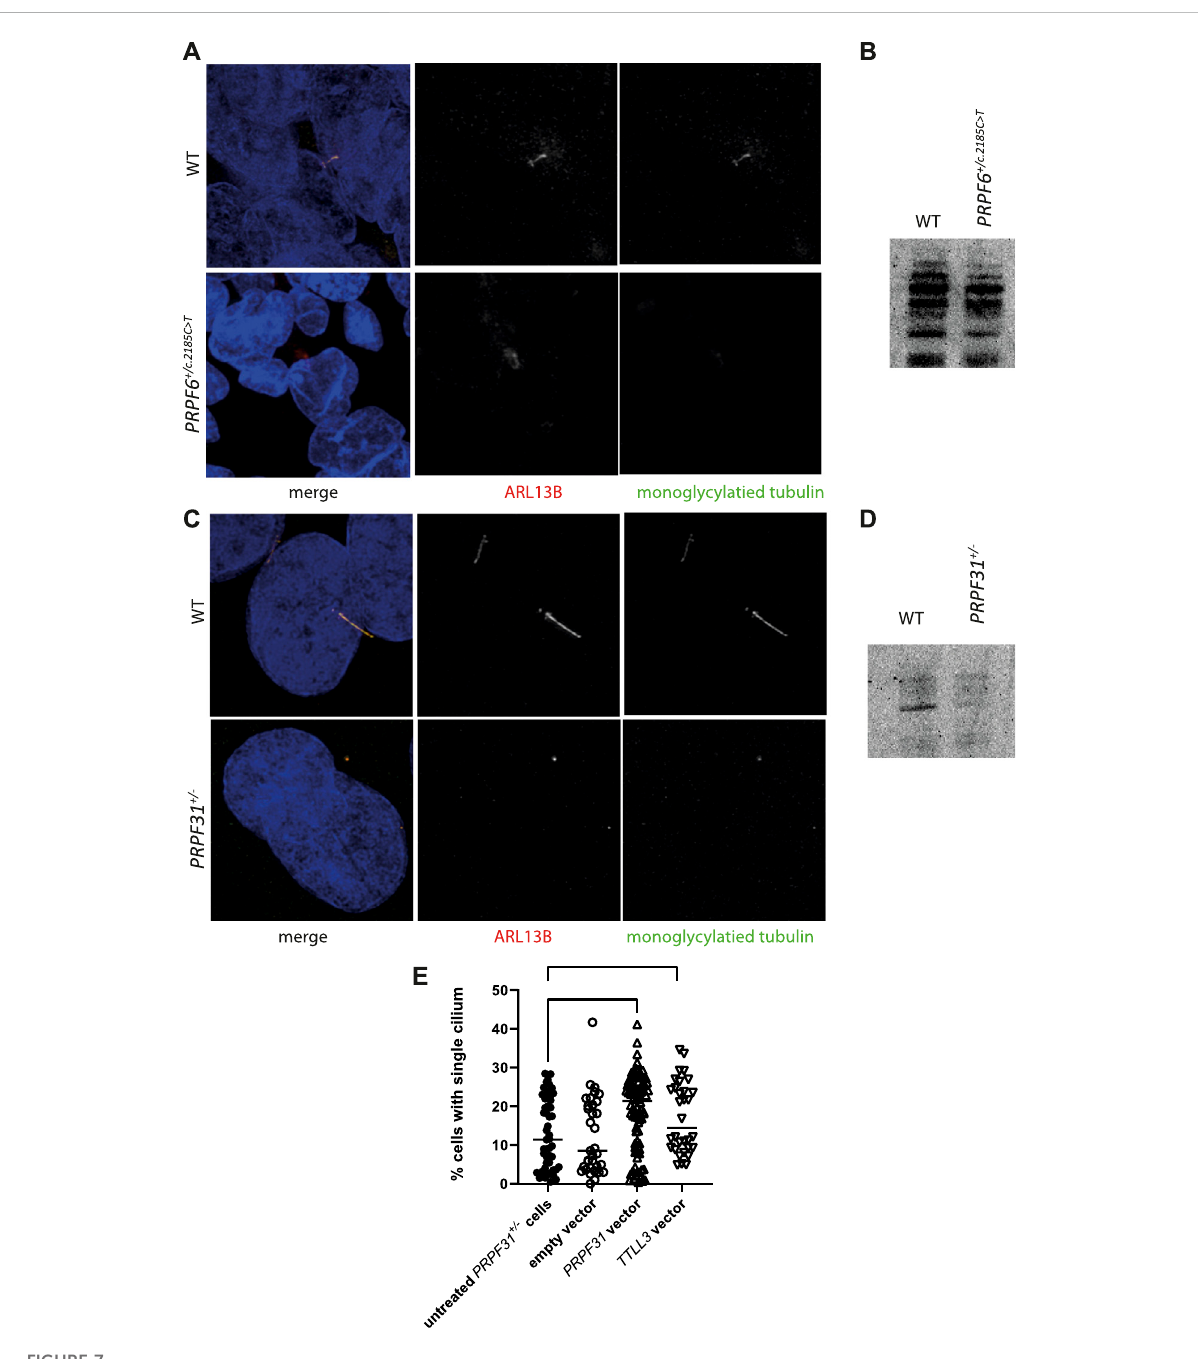
FIGURE 7 Analysisofmonoglycylationin PRPF6 +/c.2185C > T cellsand PRPF31 +/ − cells,andrescueofciliationin PRPF31 +/ − cells. (A) ConfocalimageofWTcells and PRPF6 +/c.2185C > T cells immunostained with cilia marker anti ARL13B (red) and anti monoglycylated tubulin (green) antibody showing loss of monoglycylated tubulin from the cilium of mutant cells. (B) Western blot image showing reduction in levels of total monoglycylated tubulin in PRPF6 +/c.2185C > T cells compared to WT sister clones. (C) Confocal image of WT cells and PRPF31 +/ − cells immunostained with cilia marker anti ARL13B (red) and anti monoglycylated tubulin(green) antibody showing loss of cilia from PRPF31 +/ − cells, but retention of monoglycylated tubulin at the basal body. (D) Western blot image showing reduction in levels of total monoglycylated tubulin in PRPF31 +/ − cells compared to WT sister clones. (E) Dot plot showing percentage of cells with a single cilium in untreated PRPF31 +/ − cells, and in PRPF31 +/ − transfected with an empty vector, a positive control rescue vector ( PRPF31 ) or a TTLL3 expression vector, showing statistically signi fi cant increase in percentage of cells with a single cilium in mutant cells transfected with either PRPF31 or TTLL3